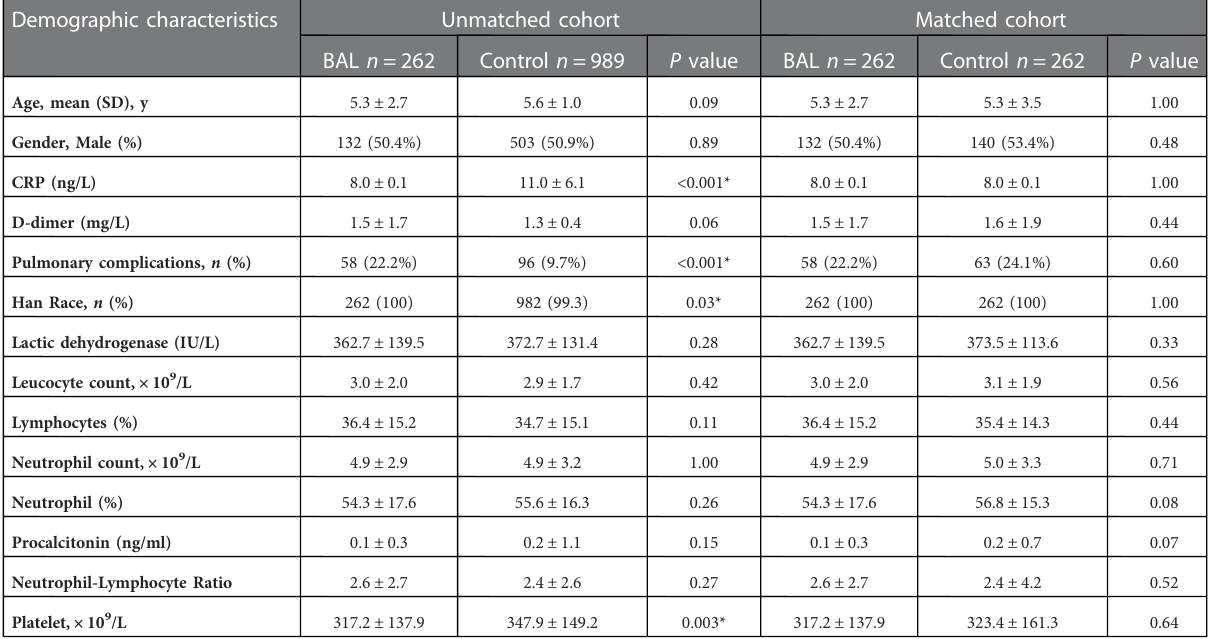
TABLE 1 Baseline characteristics before and after propensity score matching.